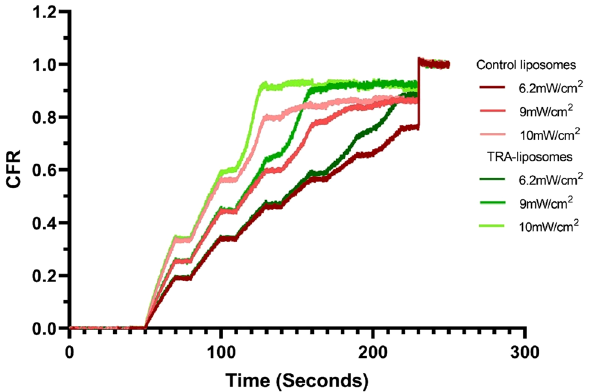
Figure 2. Normalized release profiles of the control and TRA-liposomes loaded with calcein at 6.2 mW/cm 2 , 9 mW/cm 2 and 10 mW/cm 2 . Results are the average of three batches of liposomes with three replicates each.